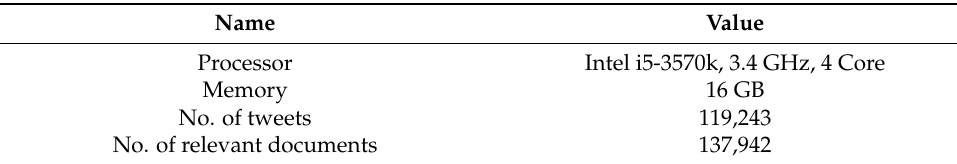
Table 1. The experimental environment.